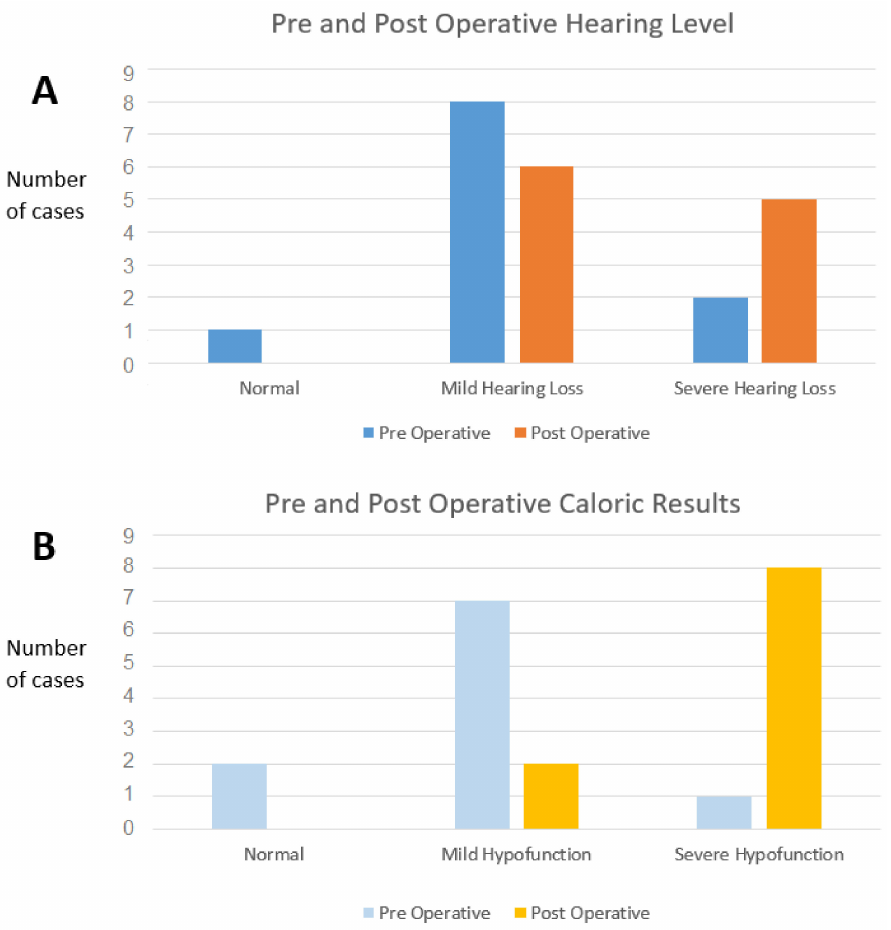
Figure 4. Pre- and post-surgery results with caloric test and pure tone audiometry (PTA). ( A ): PTA (n = 11): three cases are impaired with severe post-surgery hearing loss (18%). ( B ): Caloric test (n = 10): no areflexia was observed before surgery. After surgery, a severe hypofunction (CaT hypofunction >80%) was observed in 82% of